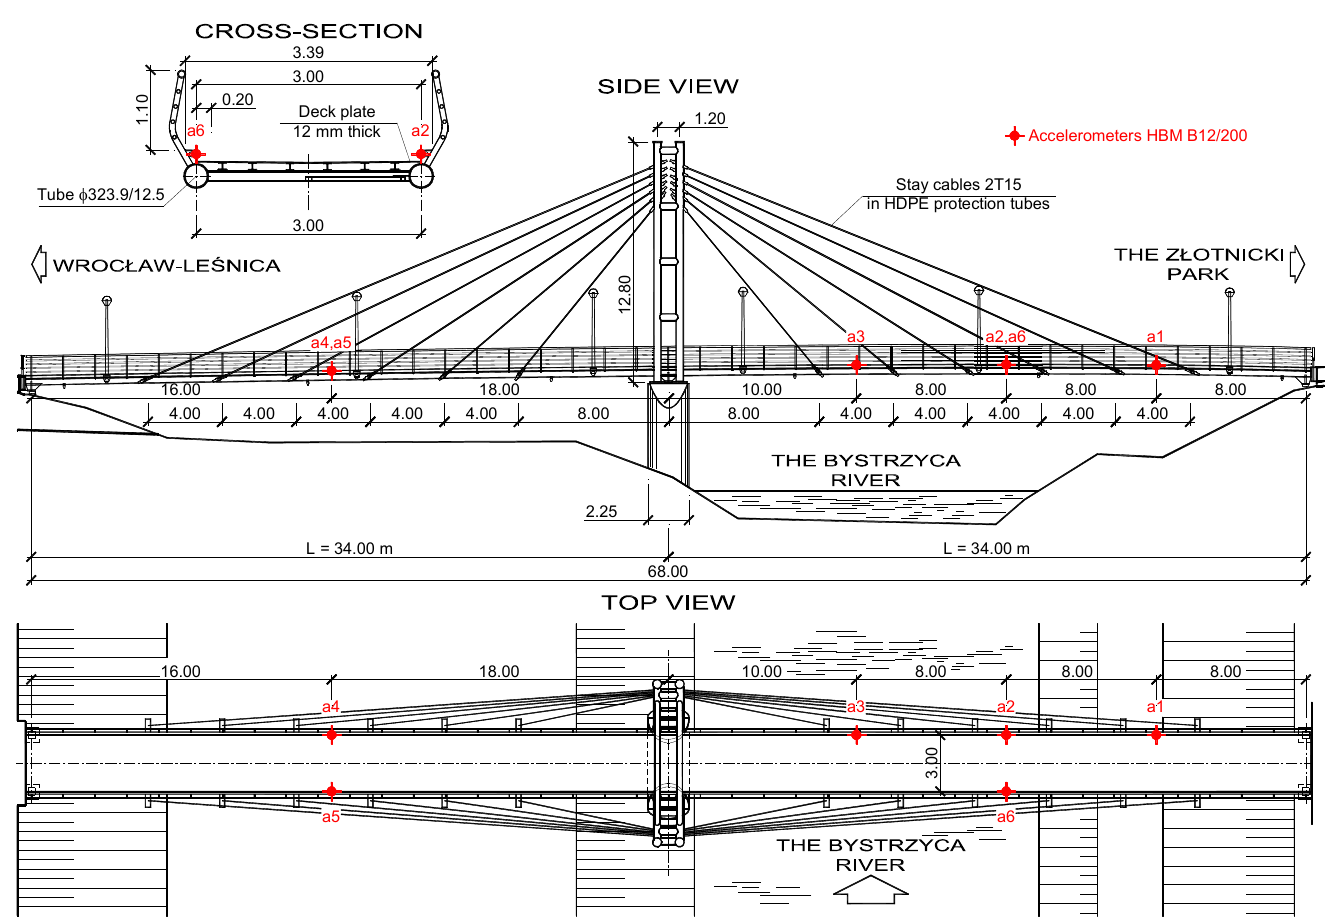
Figure 1. Technical drawing of the structure (side view, cross-section and top view), with relevant dimensions. Selected measurement point on the left span, 16.0 m from the support.